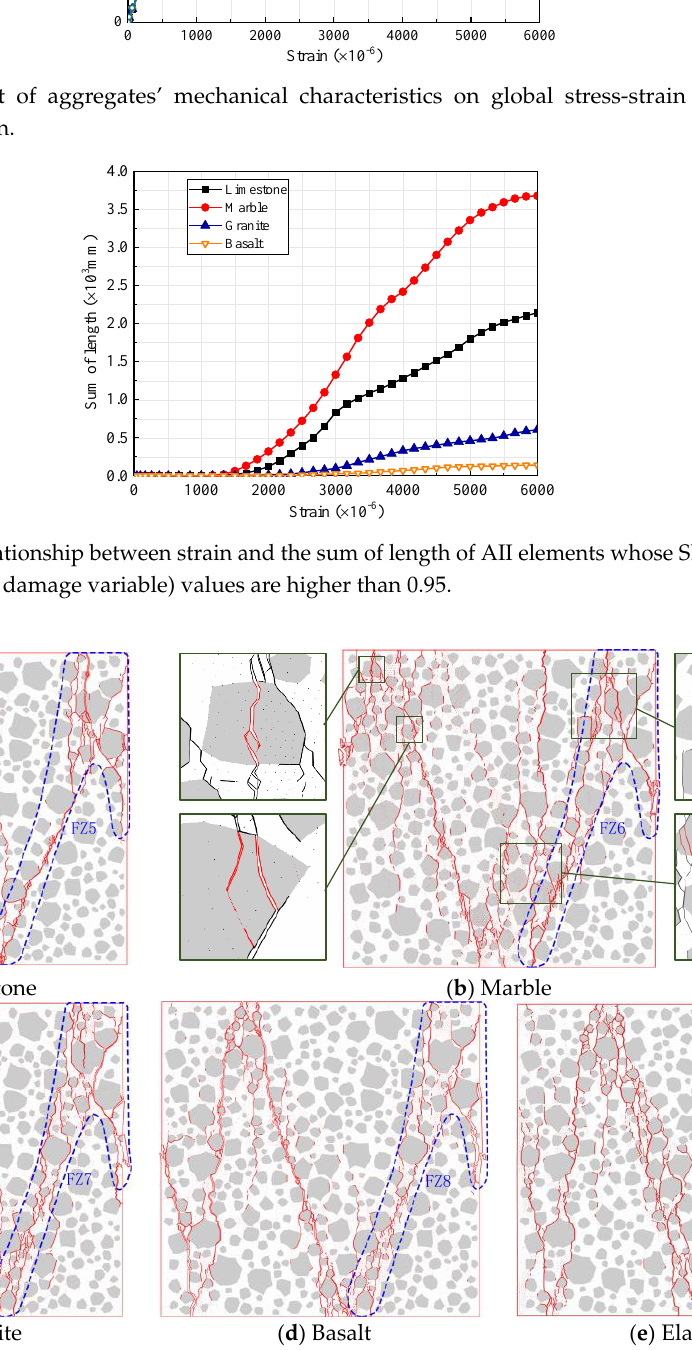
Figure 23. Failure modes of a specimen with different aggregate types; in the zoom areas of Figure 23b, the cracks through aggregates are marked by red, the others are marked by black.